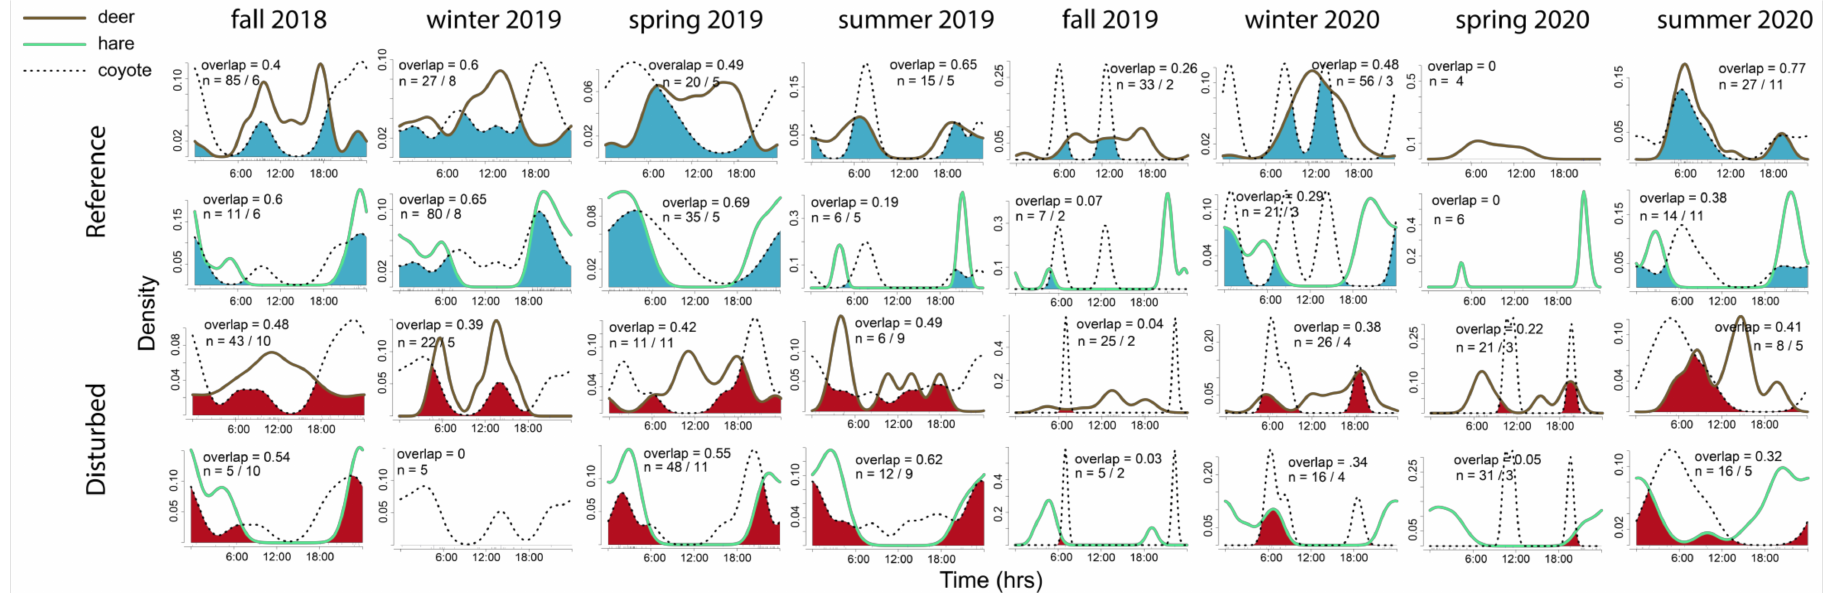
Figure 5. Seasonal daily activity plots for deer (solid brown line), hare (solid green line), and coyote (dashed black line) in the reference and disturbed forest conditions from fall 2018 to summer 2020. Activity overlap between deer and coyote or hare and coyote is shown by the shaded areas in each plot and as a percentage value. The number of individuals ( n ) is given in each plot with the first value being either deer or hare and the second coyote. Note differences in scale on